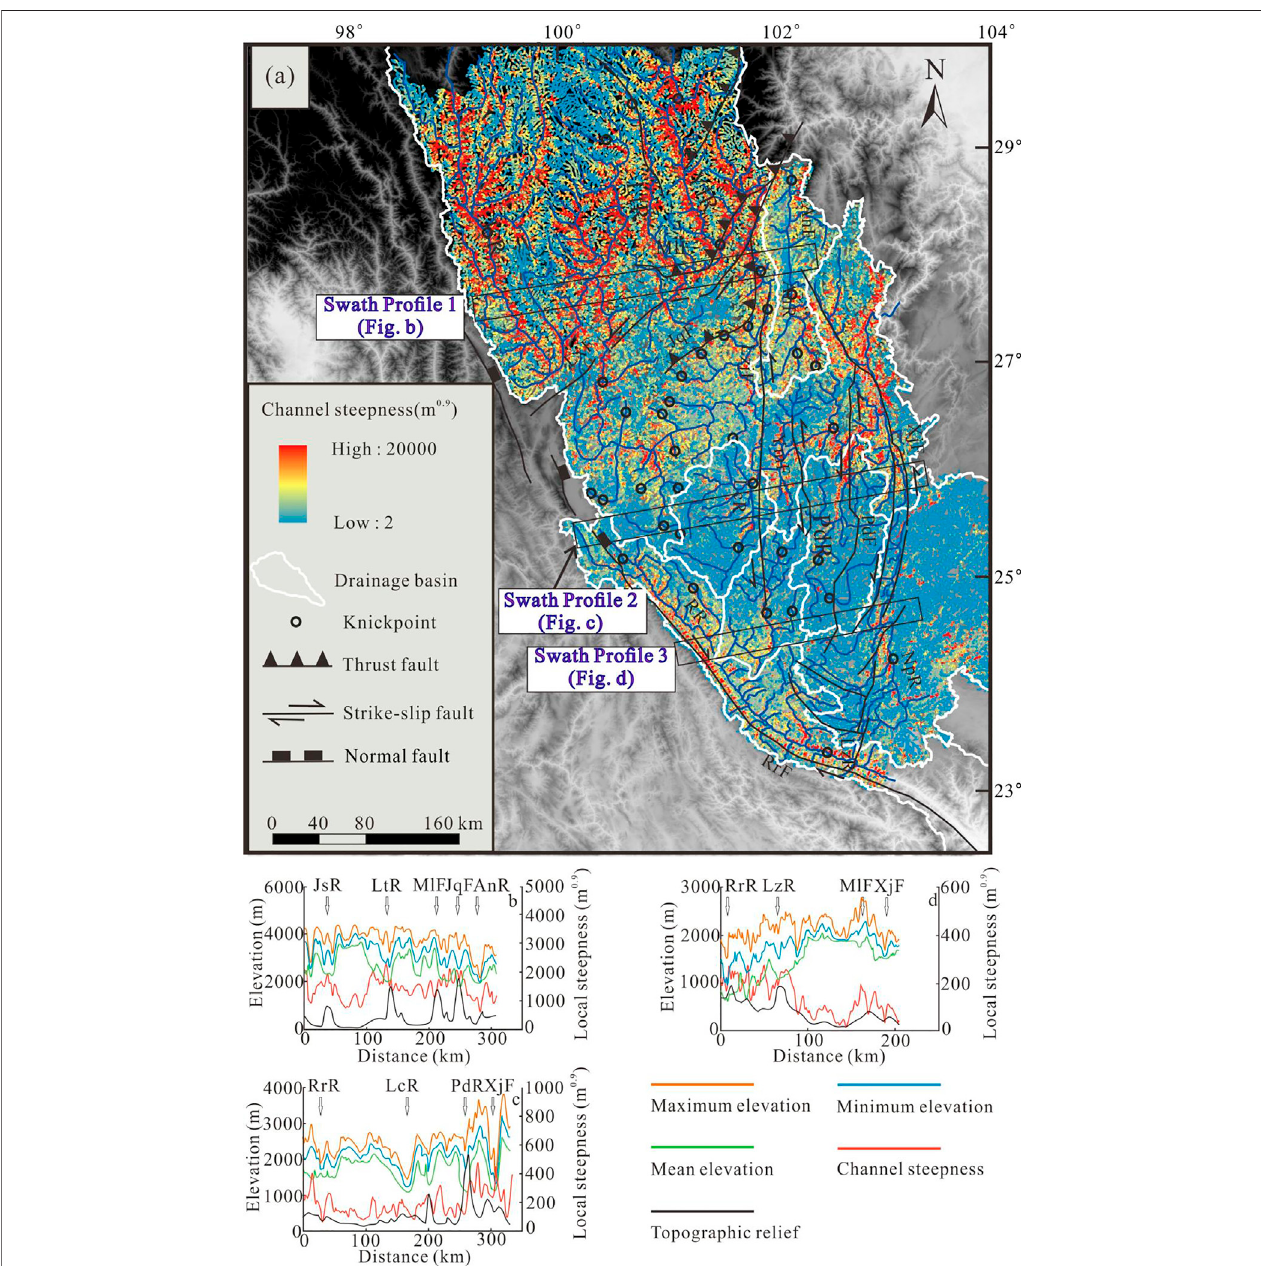
FIGURE 7 | ( A ) Map of local channel steepness values calculated under an elevation interval of 100 m. (B – D) Geological cross-sections and swath pro fi les of the elevation and local channel steepness indices along the section in (A) : swath pro fi le 1 (B) ; swath pro fi le 2 (C) ; and swath pro fi le 3 (D) . The maximum, minimum, mean elevation,andtopographicreliefareshownin orange , green , blue ,and red ,respectively.Majorfaultsandriversareasfollows: RrR ,RedRiver; LtF ,LitangFault; MlF ,Muli Fault; JqF , Jinhe – Qinghe Fault; JsR , Jinsha River; LtR , Litang River; LcR , Longchuan River; LzR , Lvzhi River; PdR : Pudu River; XjR , Xiaojiang River. Average local steepness indices are shown in black